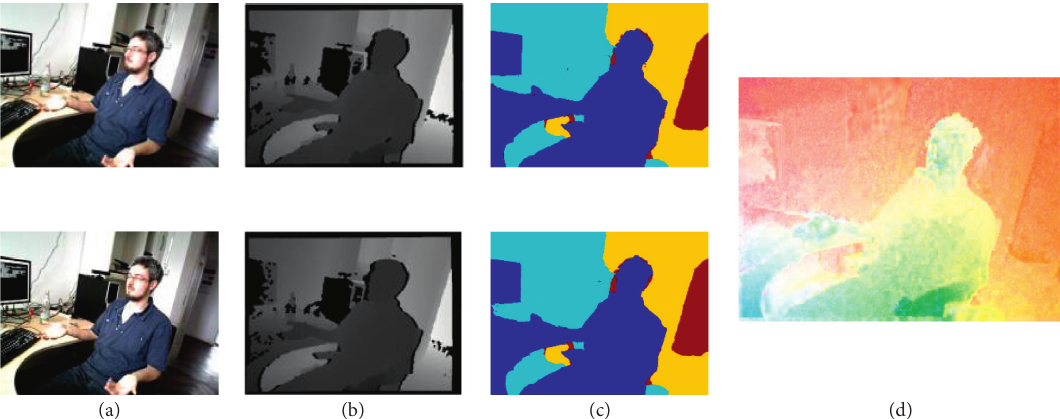
Figure 4: SRSF 20 sequence [27] without spatial constraints of scene flow. Two consecutive frames from SRSF 20 sequence are input and segmented into 4 regions to estimate scene flow. (a) RGB images. (b) Depth images. (c) Segmentation K � 4. (d) Scene